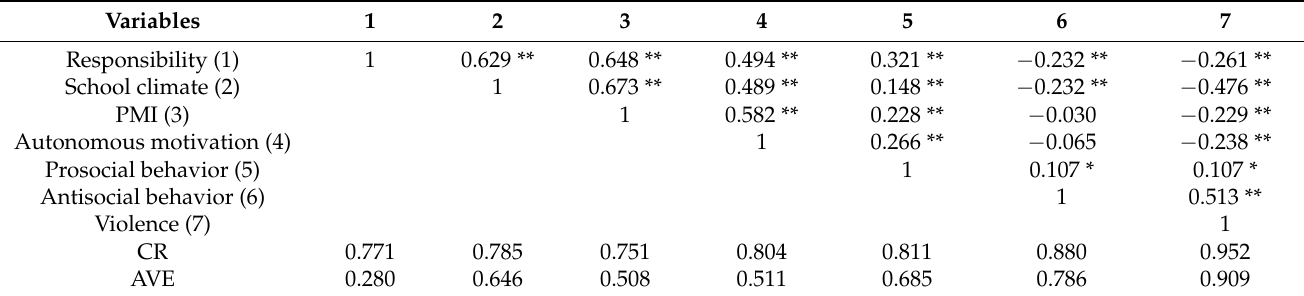
Table 4. Correlations between